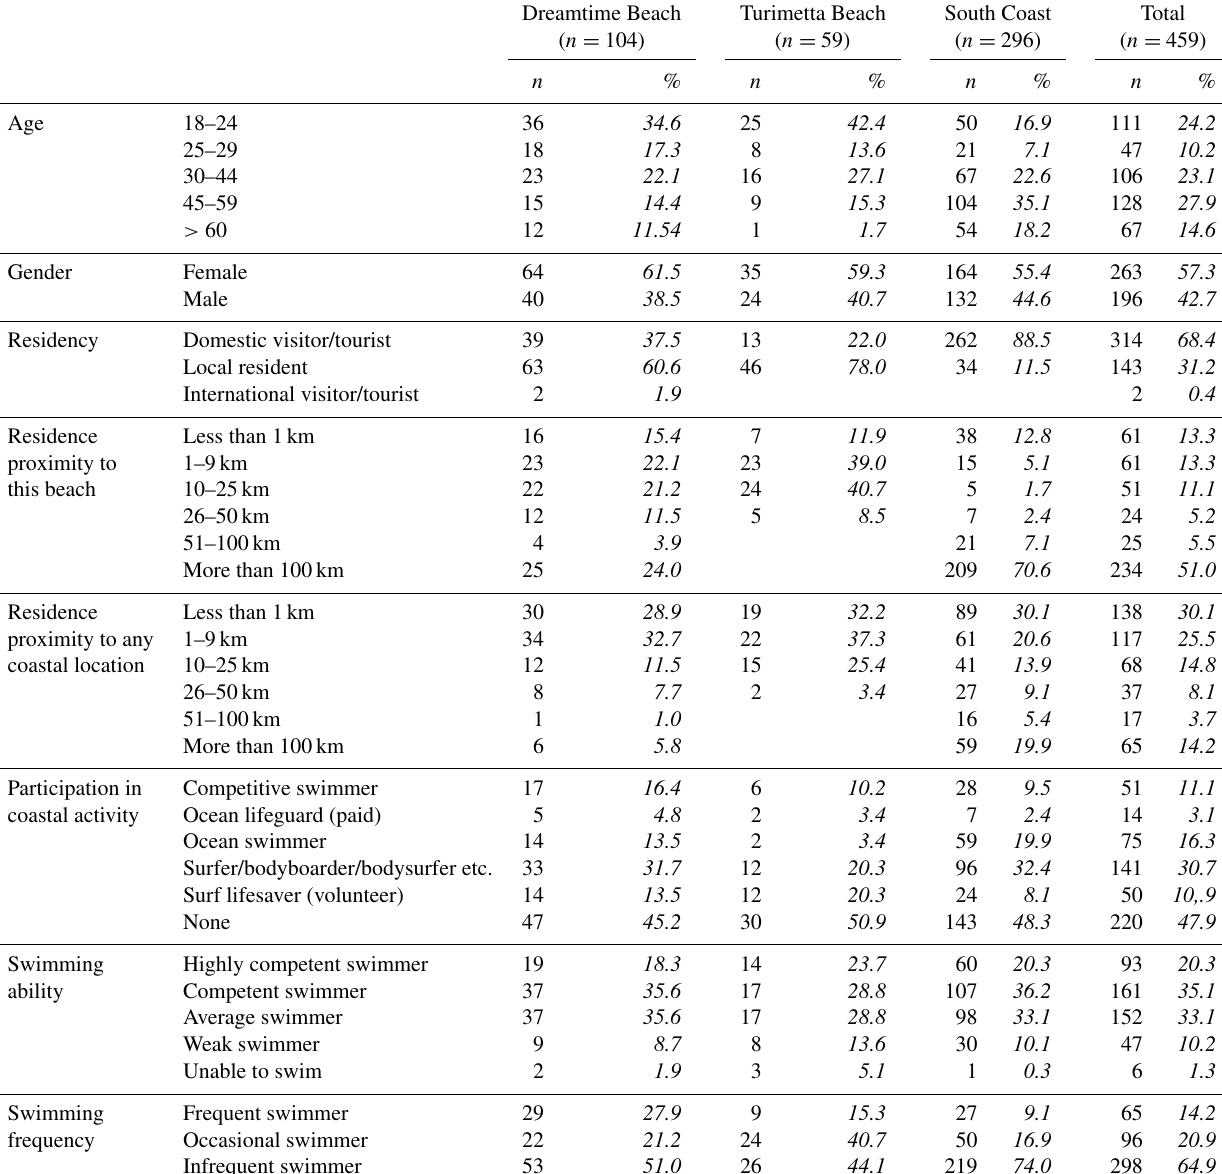
Table 1. Characteristics of surveyed beachgoers in terms of demographics, residence proximity to the beach and coast, participation in coastal activities, swimming ability, and swimming frequency. Percentages are shown in